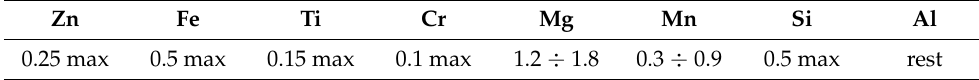
Table 1. Chemical composition of the EN AW-2024-T3 aluminum alloy (wt.%) [31].